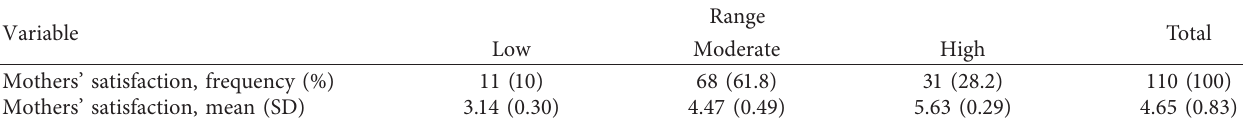
Table 3: The amount of mothers’ satisfaction from neonatal care in NICU ( n � 110). Variable